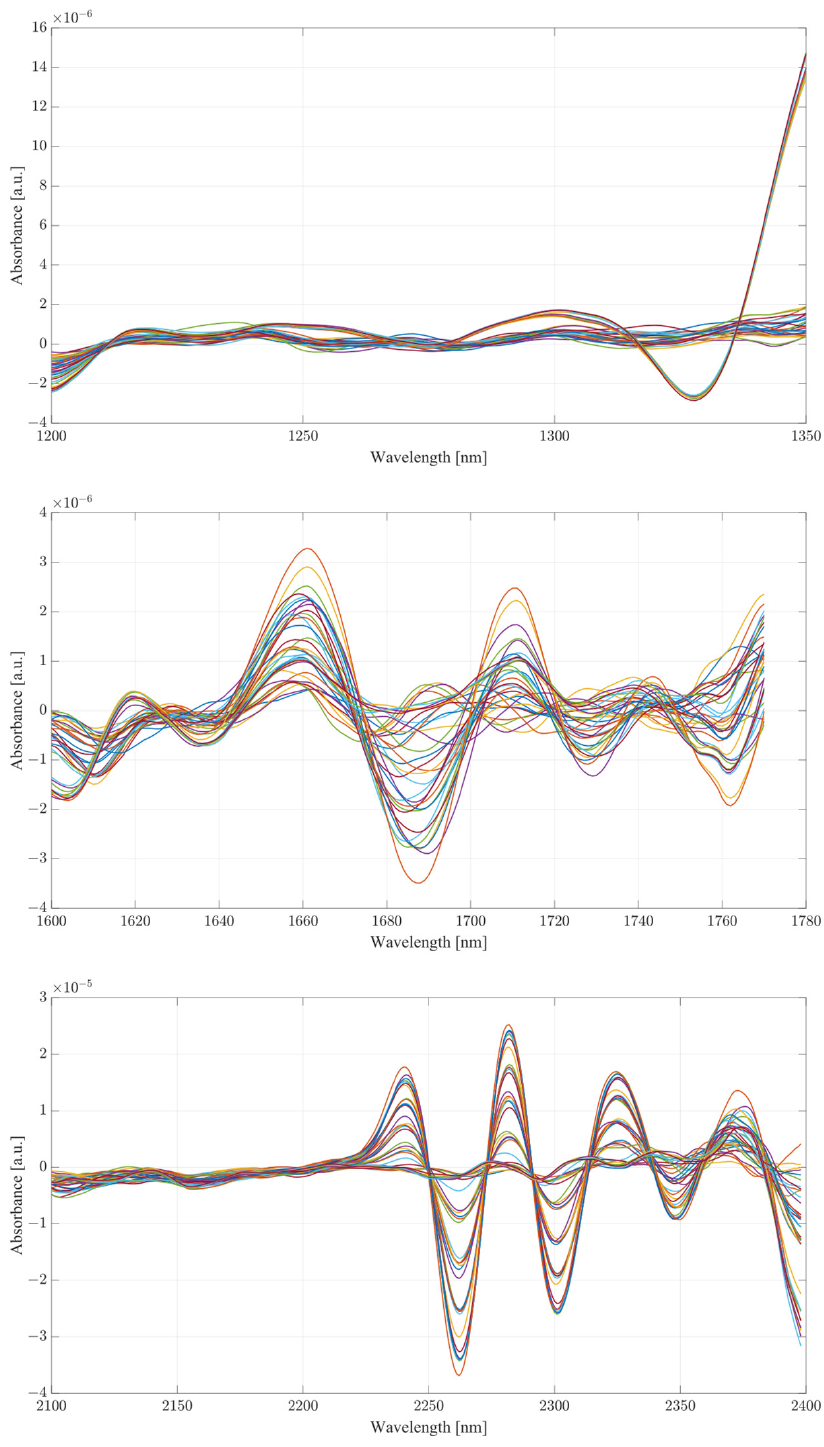
Figure 4. Water mixture results, from top to bottom: raw spectra, postbaseline subtraction, second derivative, therapeutic window II, therapeutic window III, therapeutic window IV.